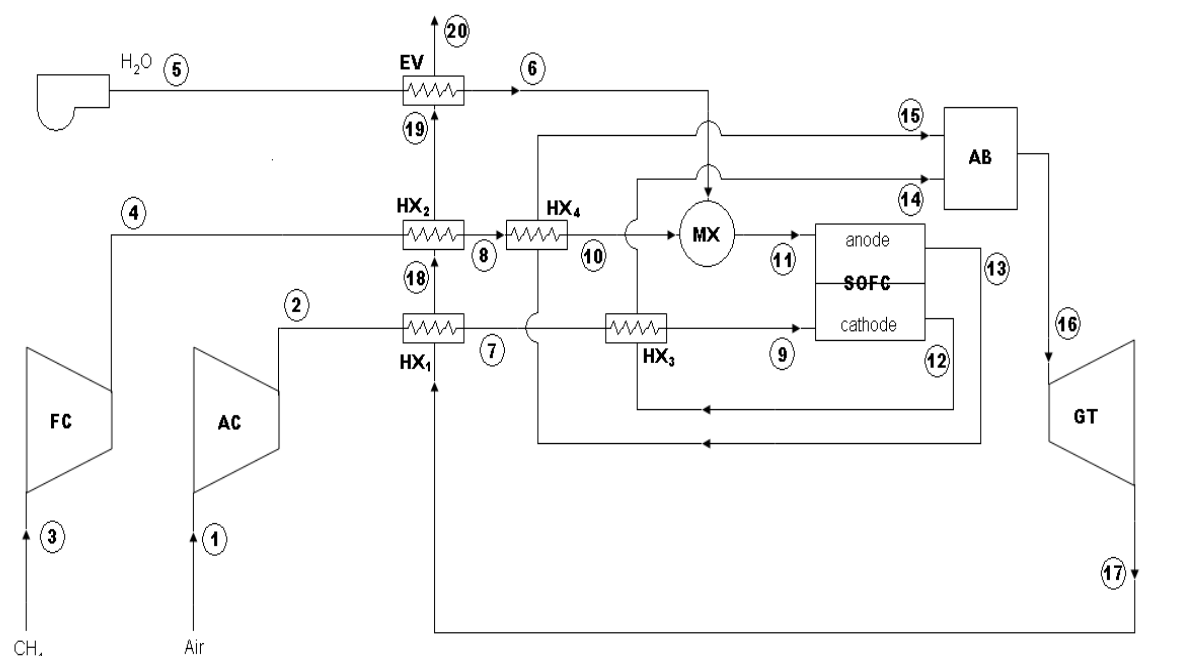
Figure 1. Schematic of the proposed hybrid power